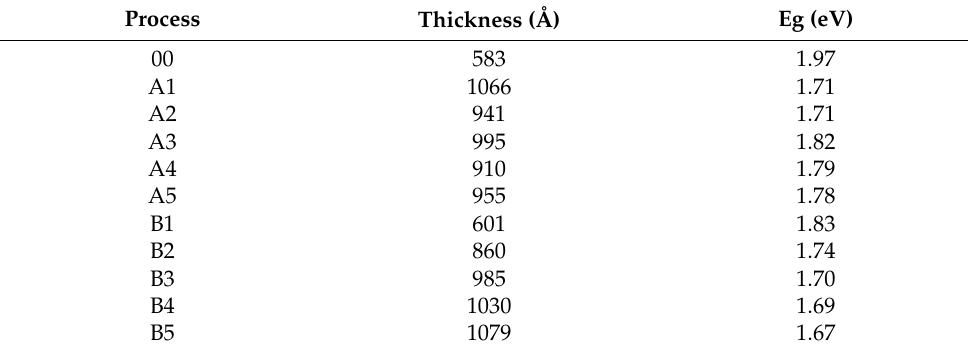
Table 2. Thickness and energy gap of the three